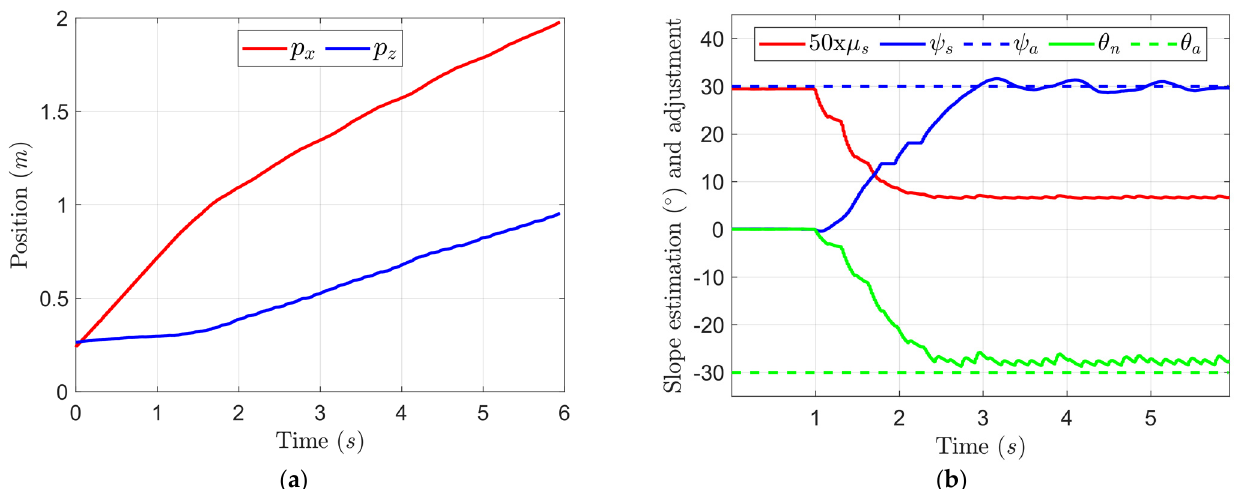
Figure 9. Uphill process of the unknown slope. ( a ) CoM position on a sagittal plane; ( b ) Estimation and adjustment.